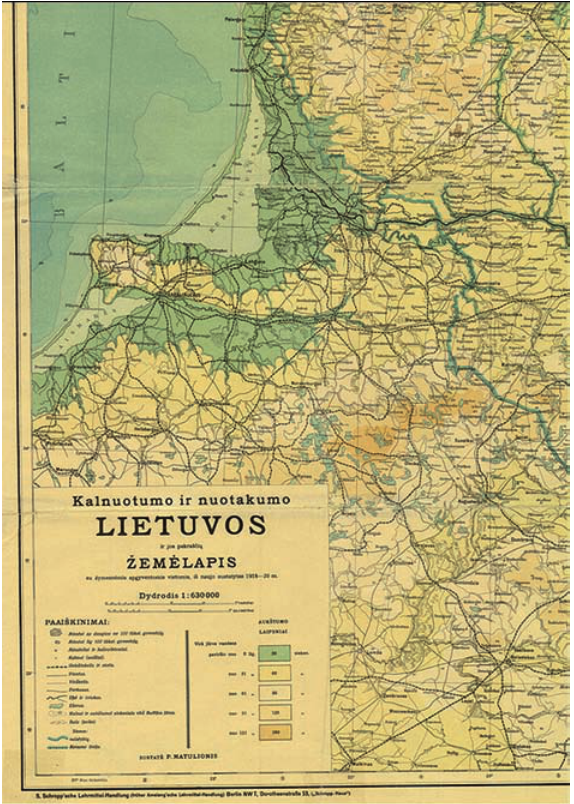
Fig. 1. Fragment of P. Matulionis map ‘‘Mountainousness and inclination map of Lithuania and